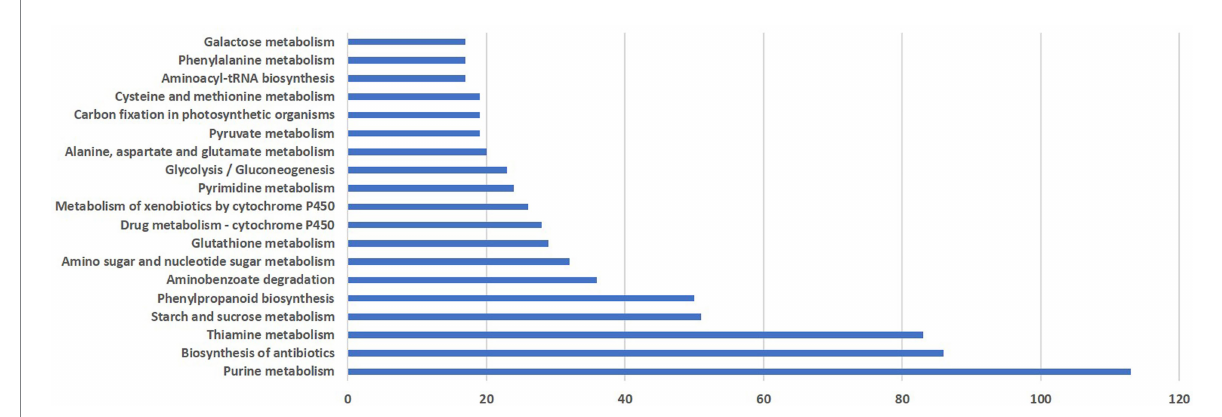
FIGURE 3 Distribution of pathways highly affected during M. grisea infection in pearl millet inbred ICMB 93333.